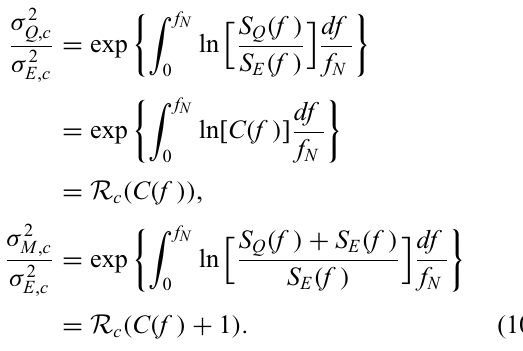
FIG. 2. (a) The step response of a fictitious 3-bit ADC with nonlinear behavior. The solid blue trace represents the actual response of the ADC and the dashed gray line represents the ideal step response. The solid red line is the analog input applied to the ADC. (b) The differential nonlinearity (DNL) of the ADC. (c) The integral nonlinearity (INL) of the ADC. (d) The output distribution of the 3-bit ADC assuming that an input with a Gaussian density function is applied. The solid blue bars represent the actual response of the ADC, the dashed black line represents the response of an ideal 3-bit ADC, and the solid red line represents the analog input. function of the